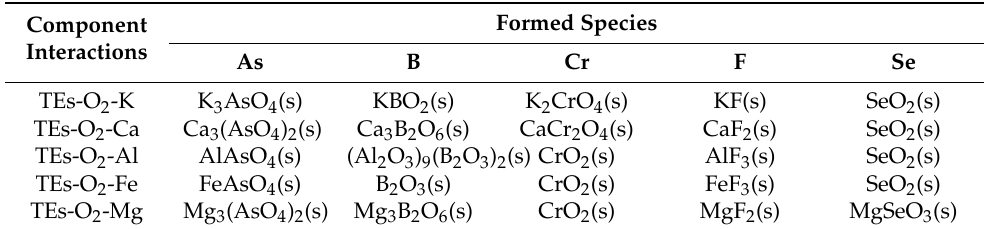
Figure 5. Equilibrium composition of Se-Mineral oxides interactions during combustion: ( a ) Se-O 2 -Al 2 O 3 ; ( b ) Se-O 2 -CaO; ( c ) Se-O 2 -Fe 2 O 3 ; ( d ) Se-O 2 -K 2 O, and ( e ) Se-O 2 -MgO. Table 3. Prediction of the main species during the interaction of trace elements with mineral oxide during the combustion